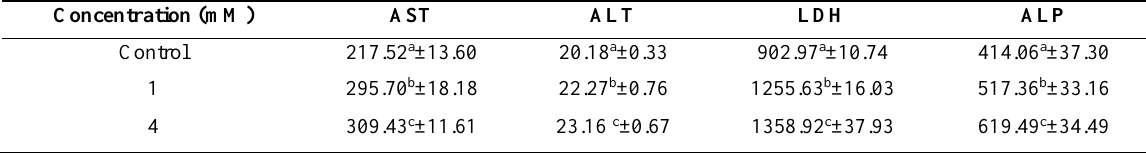
Fig. 2. Microscopic images of differentiated cells stained with acridine orange: A) control group; B) cells treated with 1 mM of DEA; C) cells treated with 4 mM of DEA; Arrows show a reduction in cytoplasm and aggregation of the cell body after treatment with 1 and 4 mM of DEA (200 magnifications). Table 3. Effect of DEA on the activity (IU/L) of AST, ALT, LDH, and ALP of differentiated cells after 21 days of